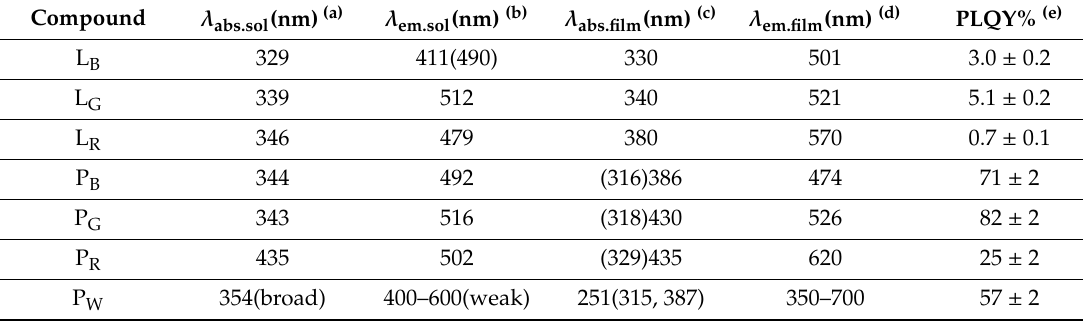
Table 2. Optical data of ligands and